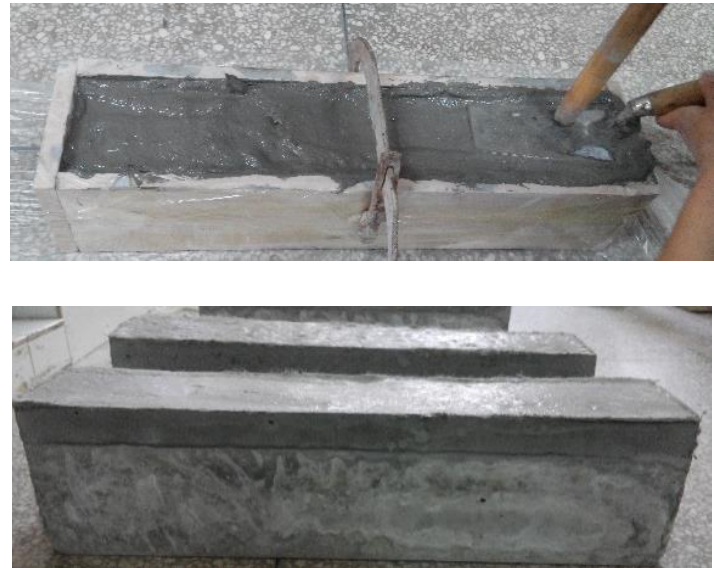
Figure 6. Repaired concrete beam after pouring SHCC layer.